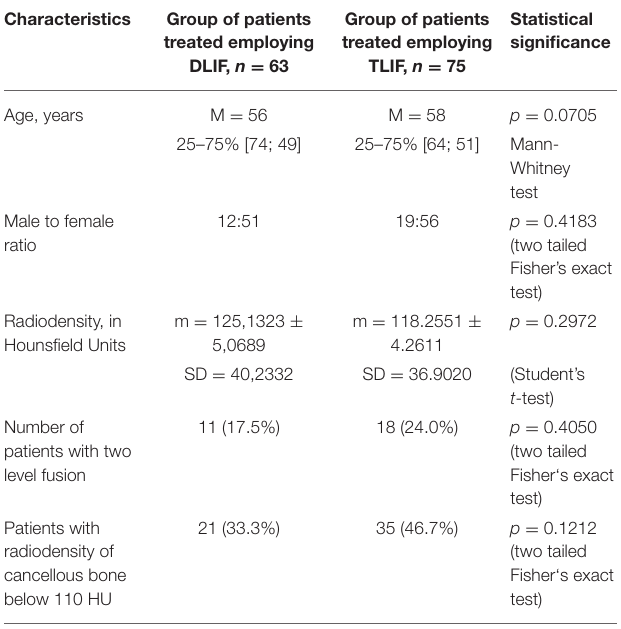
TABLE 1 | Characteristics of the enrolled groups.